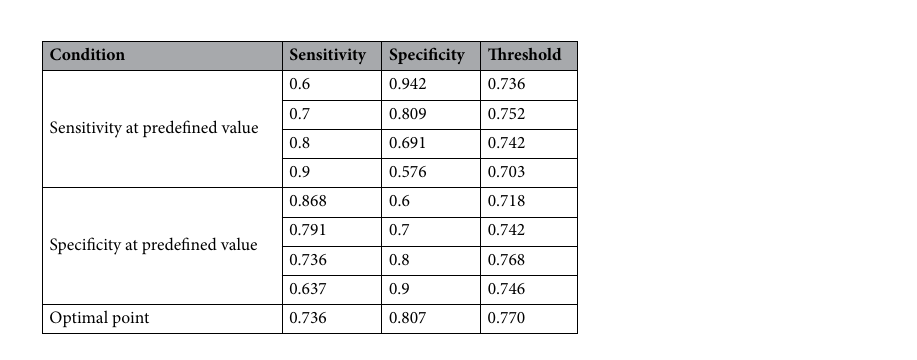
Table 1. Sensitivity, specificity, and threshold values at different operating points for RF-based pain tracking; the AUROC value of the prediction model equaled 0.853.